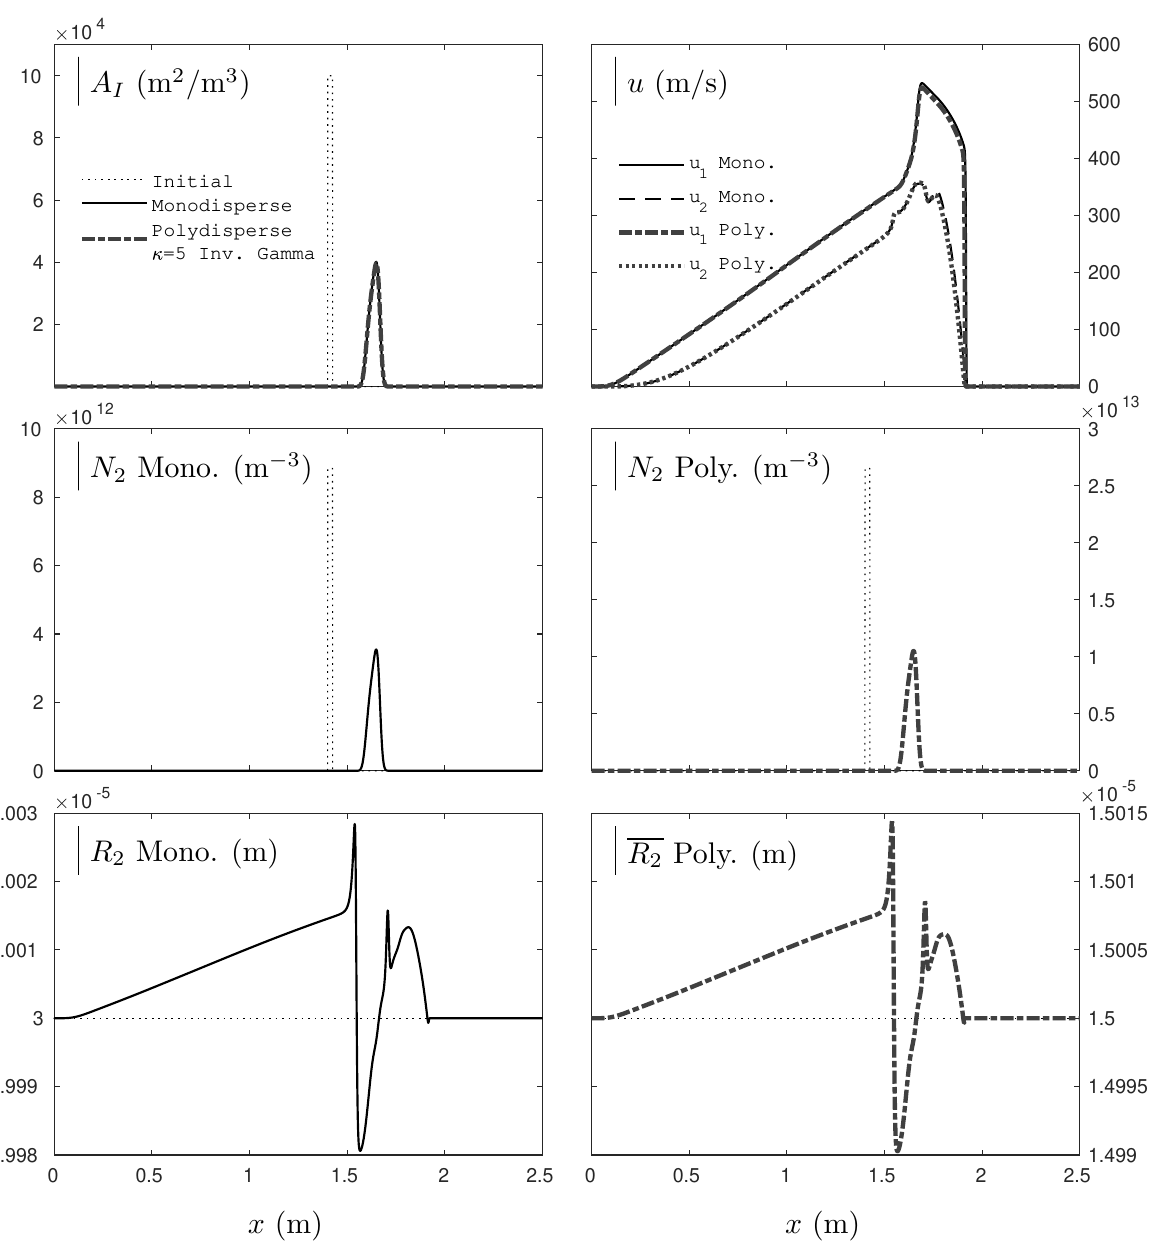
Figure 11: Simplified two-phase explosion test depicted in Fig. Figure 11. Simplified two-phase explosion test depicted in Figure 5. Comparison of the monodisperse and polydisperse results. The initial specific interfacial area is the same for both computations = 30 µ m. For